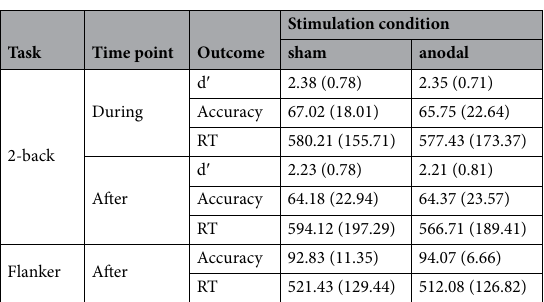
Table 2. Mean (Standard deviation) for 2-back d ′ score, accuracy (%) and reaction times (ms) and Flanker accuracy (%) and reaction times (ms). RT reaction time.